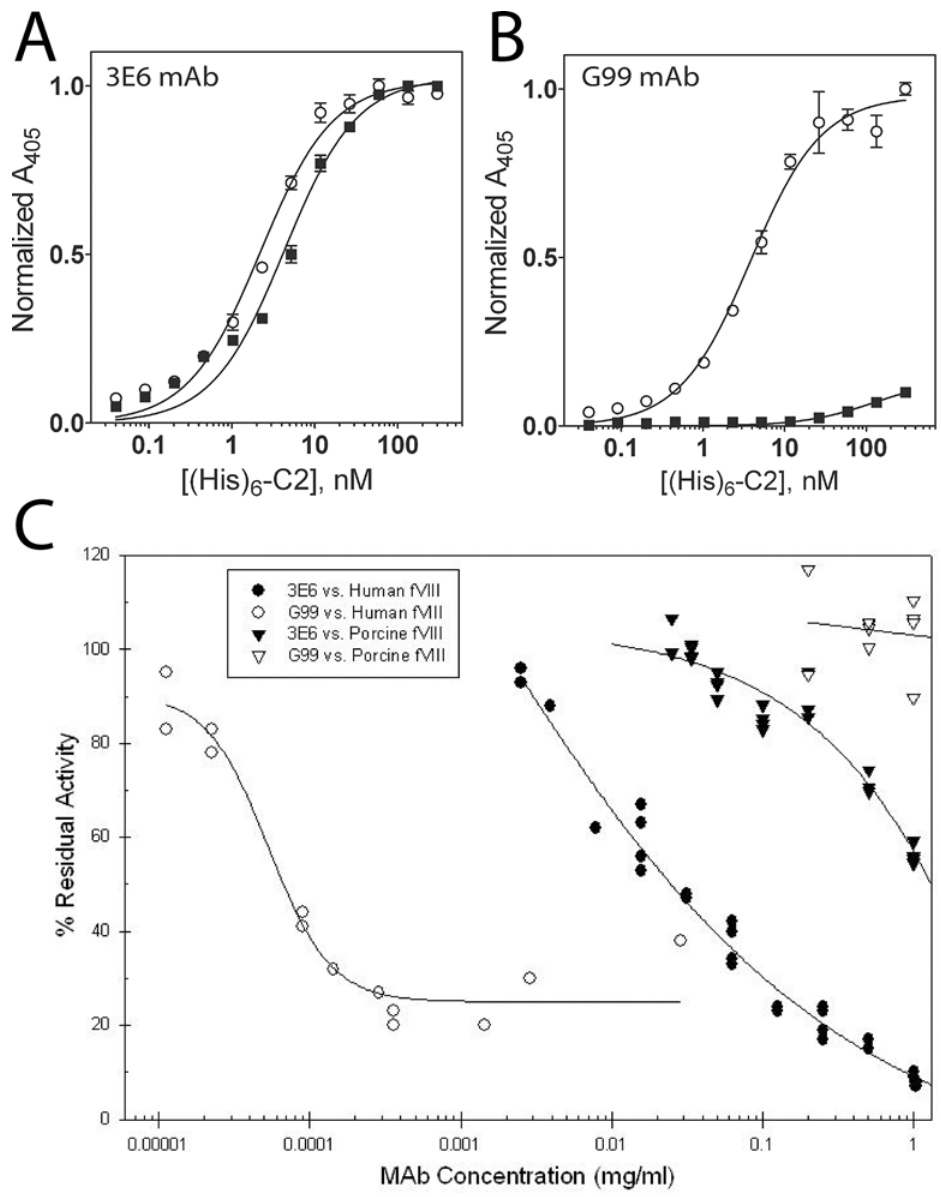
Fig 4. ELISA of human and porcine C2/mAb interactions. Binding of human (open circles) and porcine (closed squares) His 6 -C2 domain to immobilized (A) 3E6 mAb and (B) G99 mAb. Bound His 6 -C2 was detected with Ni-NTA-alkaline phosphatase. (C) Bethesda assay for 3E6 and G99 with human or porcine BDD